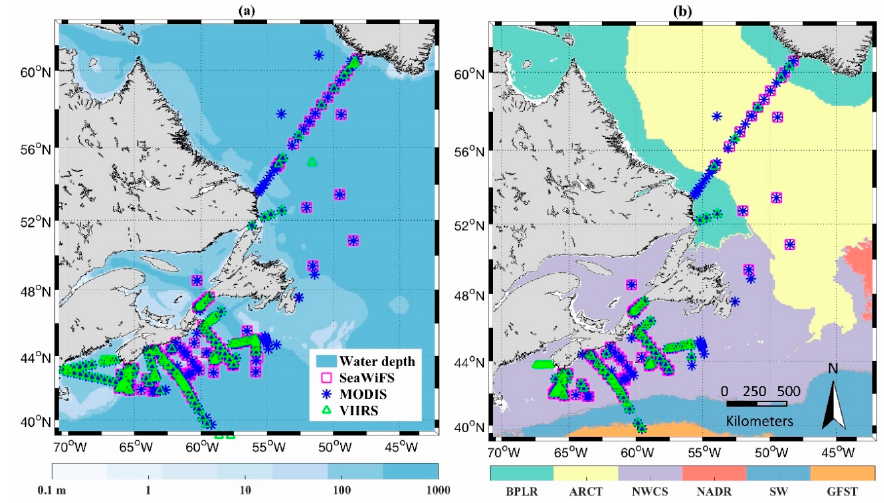
Figure 1. Location of ( a ) in situ and satellite matchups of Chl a , ( b ) in situ and satellite matchups of phytoplankton absorption, and the dynamic assignment of ecological provinces in the NWA [34].